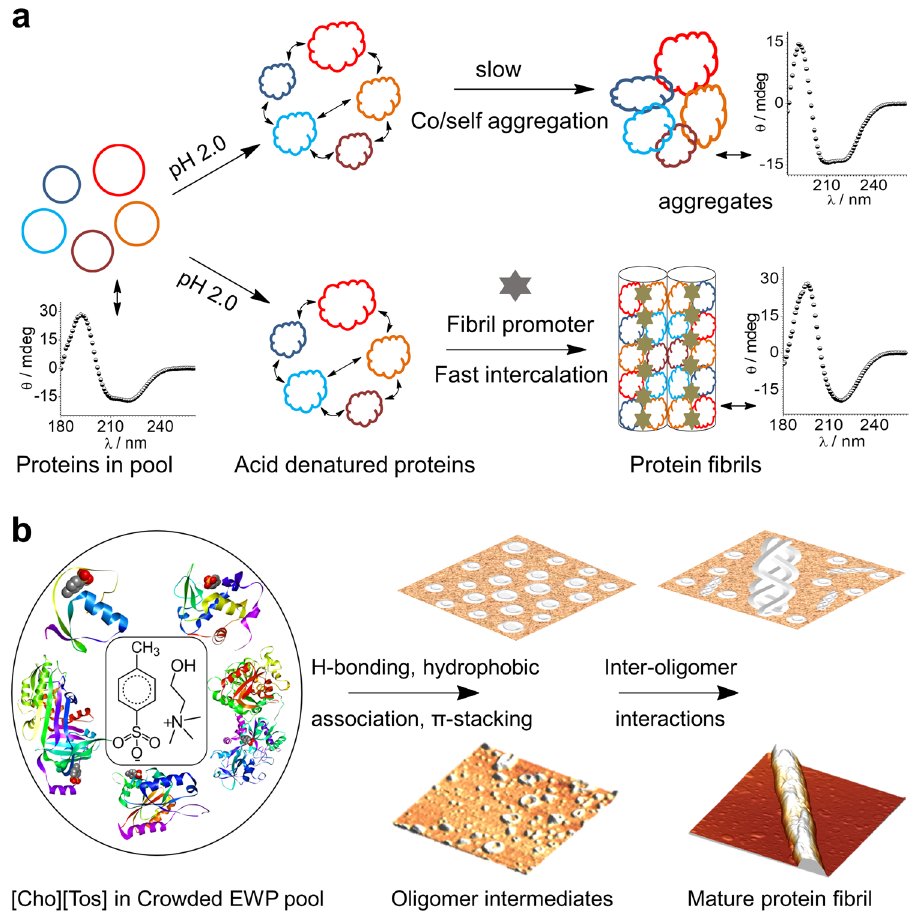
Fig. 6 Schematic overview of the fi brillation mechanism. a Cartoons summarizing the proposed fi brillation mechanism in the egg white proteome with and without the fi brillation agent ([Cho][Tos]) along with the circular dichroism spectra (double sided arrows ( ↔ ) in the acid denatured proteins indicate the interactions between different proteins). b Schematic representation of the formation of protein fi brils from the egg white proteome using [Cho][Tos], which interacts via hydrogen bonding, hydrophobic, and π -stacking interactions with different proteins to form oligomer intermediates and protein fi